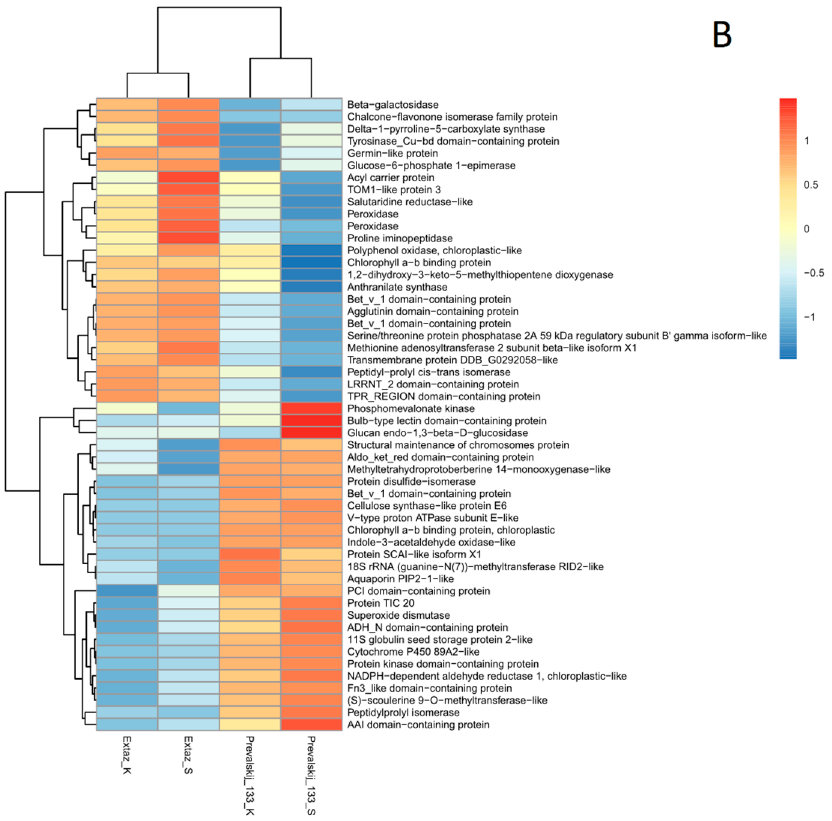
Figure 1. Heatmap showing ( A ) DEGs and ( B ) DEPs in Papaver somniferum . The relative differential gene expression was computed using read counts (for genes), or normalized protein intensity signals (for proteins), respectively. The columns marked Extaz_K and Prevalskij 133_K are plants in the control treatment. The columns marked Extaz_S and Prevalskij 133_S are plants in the stress treatment. The red color indicates up-regulated DEGs/DEPs, whereas the blue color indicates down-regulated